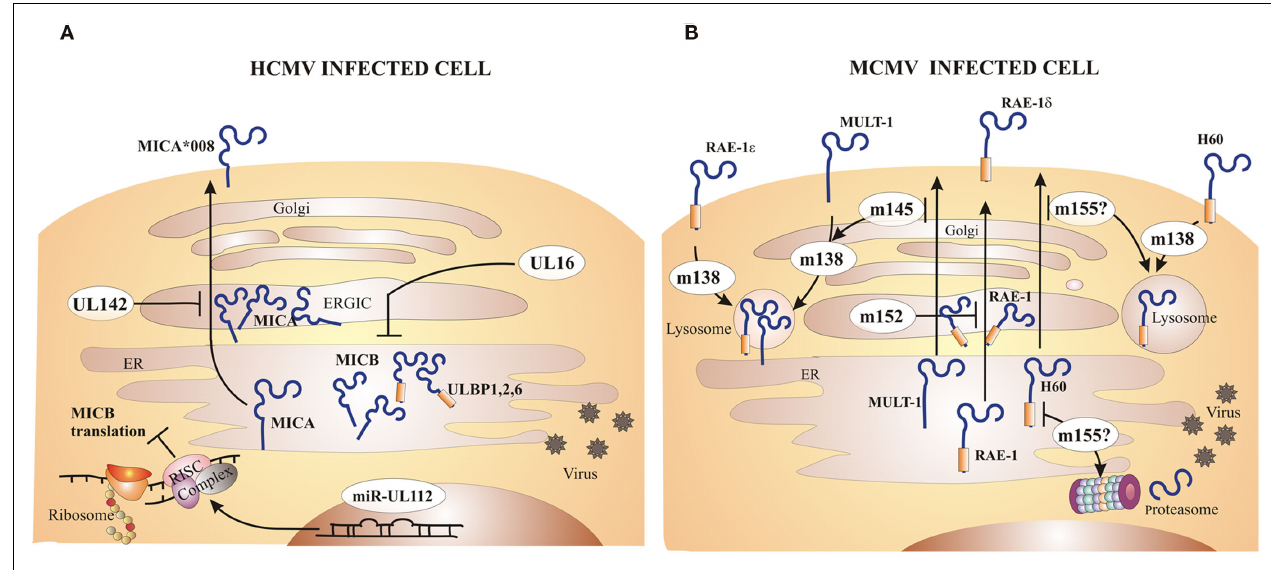
immunoevasins that redundantly downmodulate all mouse NKG2D ligands. The m152 product retains RAE-1 family of proteins in ER/ cis -Golgi compartment. Not all RAE-1 proteins are equally susceptible to inhibition by MCMV, namely RAE-1 δ is more resistant than other RAE-1 proteins.The m145 product interferes with MULT-1 expression by making it more susceptible to the inhibition by the other immunoevasin, m138 .The m155 product redirects H60 for lysosomal and/or proteasomal degradation. Surface RAE-1 ε , MULT-1, and H60 are additionally downmodulated by m138 which interferes with their